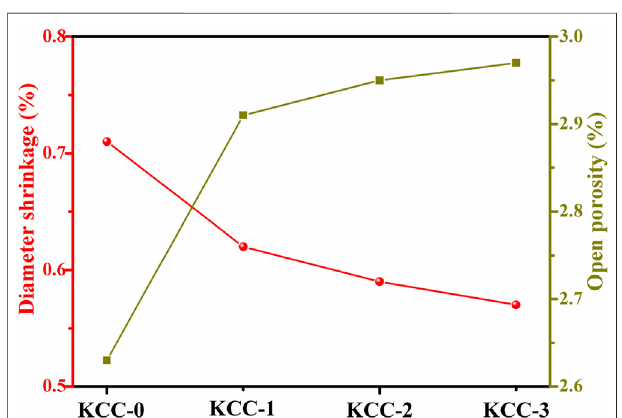
FIGURE 5 | Diameter shrinkage and open porosity of the kaolin